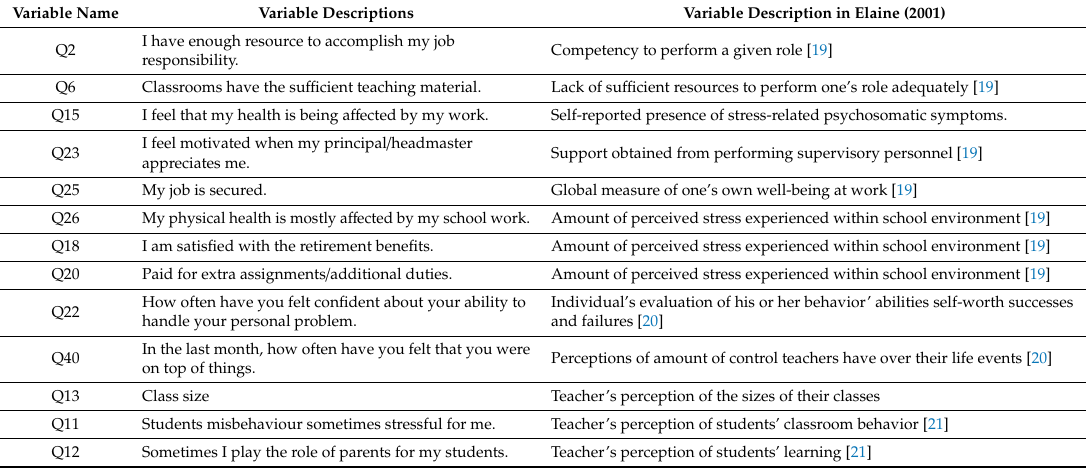
Figure 2. Theoretical causal model. Table 1. Variable specification in a causal model.